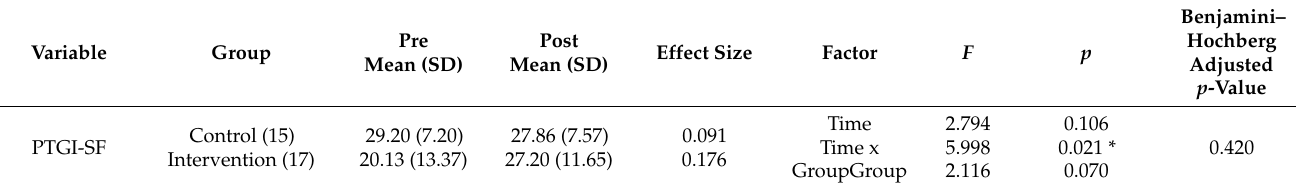
Table 3. Results for IG and CG pre- and